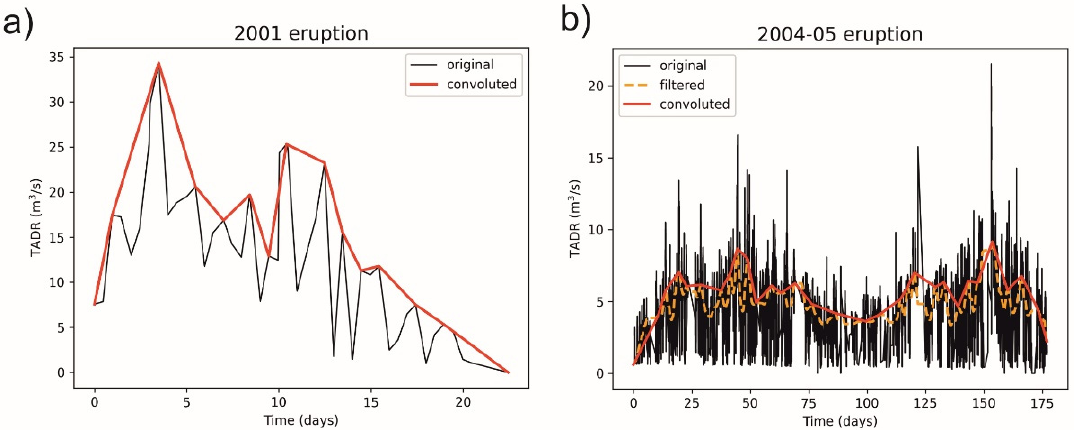
Figure 2. Examples of ( a ) convoluted and ( b ) filtered (dashed orange line) and convoluted (red line) TADR curves estimated from the satellite infrared data.